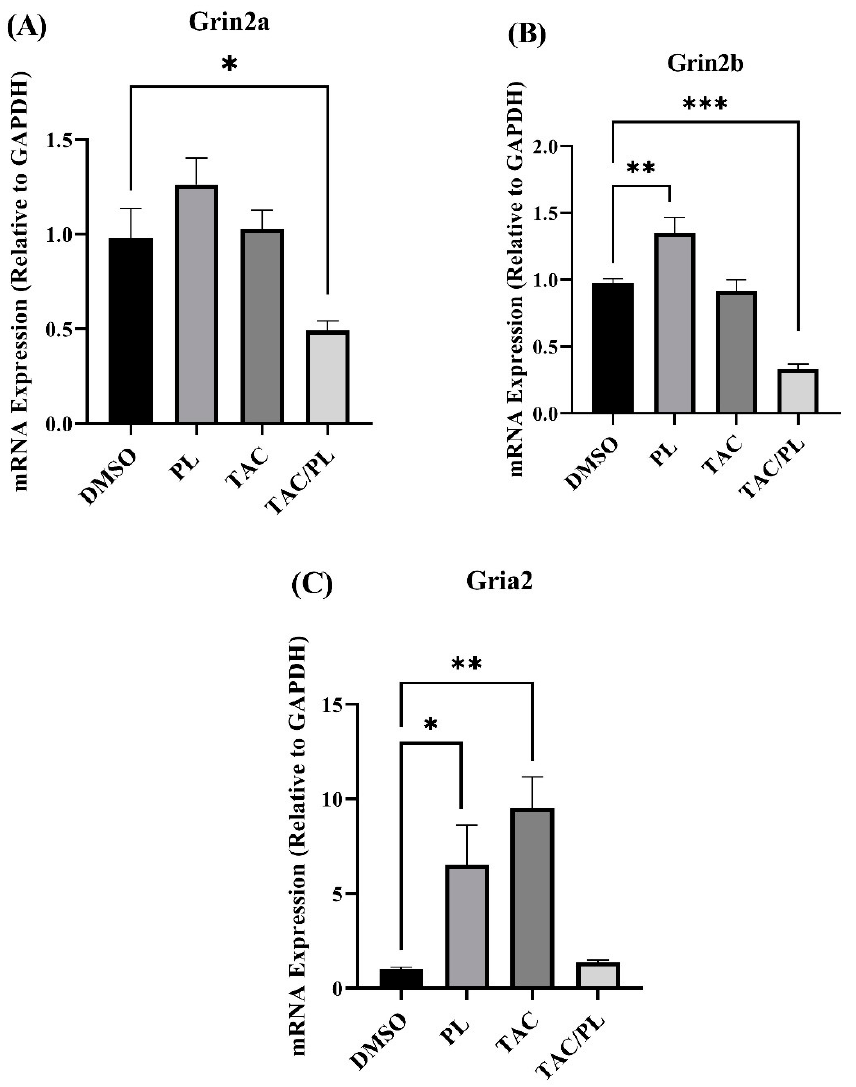
Figure 8. Changes in mRNA levels of genes encoding NMDA and AMPA receptor subunits ( A ) TAC/PL treatment reduced mRNA levels of Grin2a. ( B ) PL treatment increased and TAC/PL treatment reduced mRNA levels of Grin2b. ( C ) PL and TAC treatments increased mRNA levels of Gria2. One-way ANOVA, average ± SEM; Bonferroni multiple comparisons * p < 0.05, ** p < 0.01, *** p < 0.001. DMSO n = 7; PL n = 9; TAC n = 8; TAC/PL n =